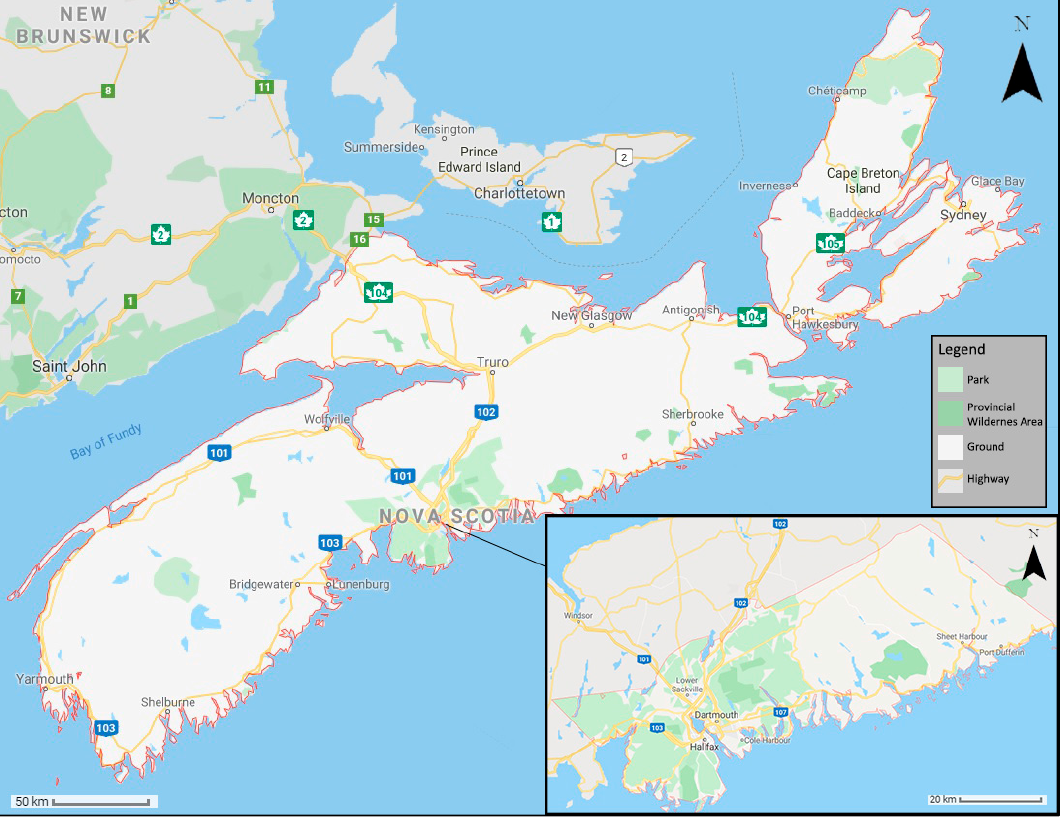
Figure 1. Location of NS on the eastern coast of North America. Land or ground is defined by white, while the darker green indicates a provincial wilderness area and the lighter green represents parkland. Inset Map: Detail map indicating location of the HRM within the province of NS. Source: © 2019 Google.